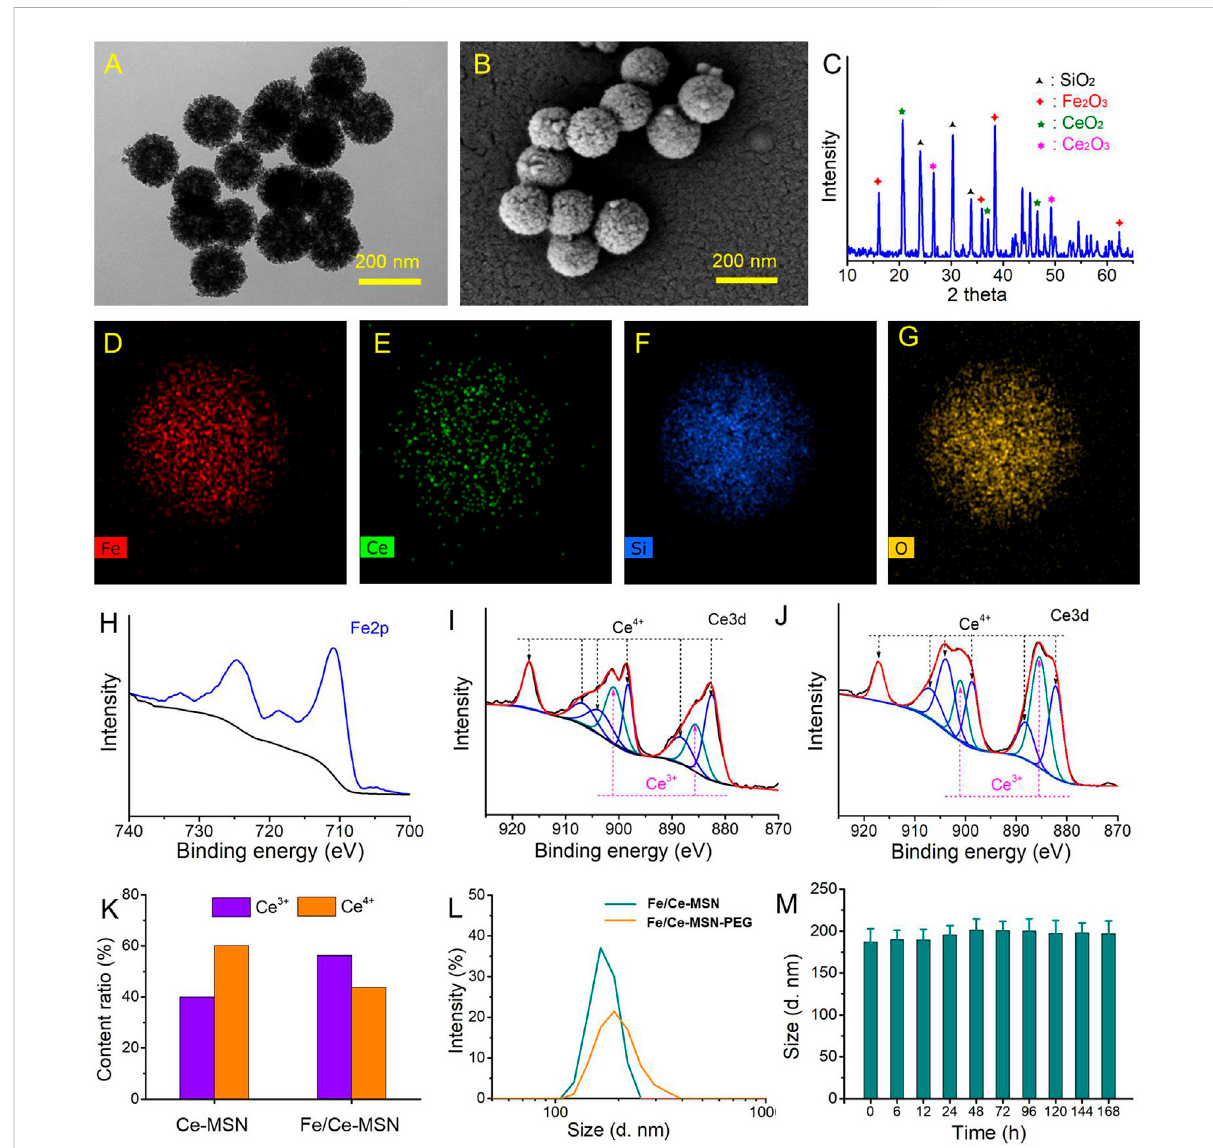
FIGURE 1 Morphological and compositional characterizations of Fe/Ce-MSN NPs: (A – C) TEM, SEM images and XRD patterns of Fe/Ce-MSN NPs. (D – G) Elemental mapping of Fe/Ce-MSN: Fe, Ce, Si, and O. h) XPS spectra of Fe 2p. (I,J) XPS spectra of Ce 3d before and after introduce Fe ions. (K) The content ratio of Ce 3+ and Ce 4+ from the XPS spectra in (I,J) . (L) Typical particle size distribution diagrams of Fe/Ce-MSN and Fe/Ce-MSN-PEG NPs. (M) thephysicalstabilityofFe/Ce-MSN-PEGNPsat37 ° Cinserum(5%,pH7.4).ThehydrodynamicsizeofFe/Ce-MSN-PEGNPswasdetermined over 1